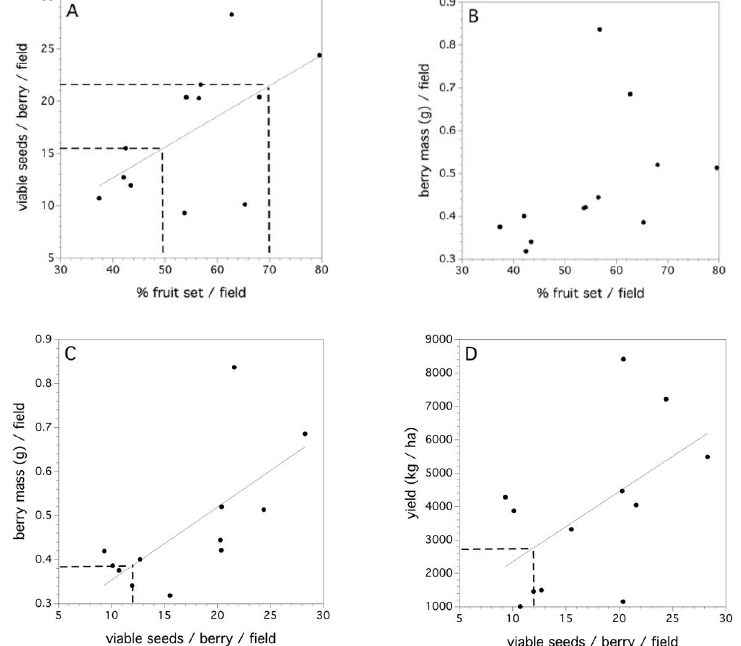
Figure 7. Field-level relationships between: ( A ) percent fruit set and average viable seeds/berry, dashed lines at 50% and 70% fruit set, ( B ) percent fruit set and average individual berry mass, ( C ) average viable seeds/berry and average individual berry mass, dashed lines at 12 viable seeds/berry, and ( D ) average viable seeds/berry and field yield (kg/ha). Solid lines are significant linear regressions fit to the aggregated field level data.